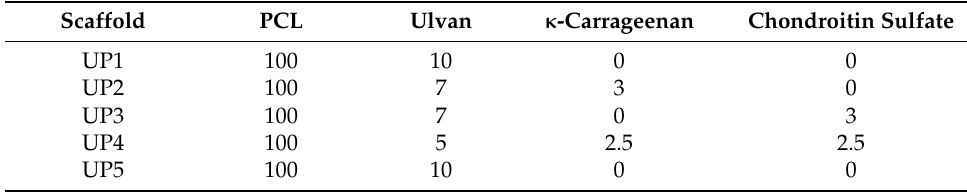
Table 3. Composition ( w / w ) of UP